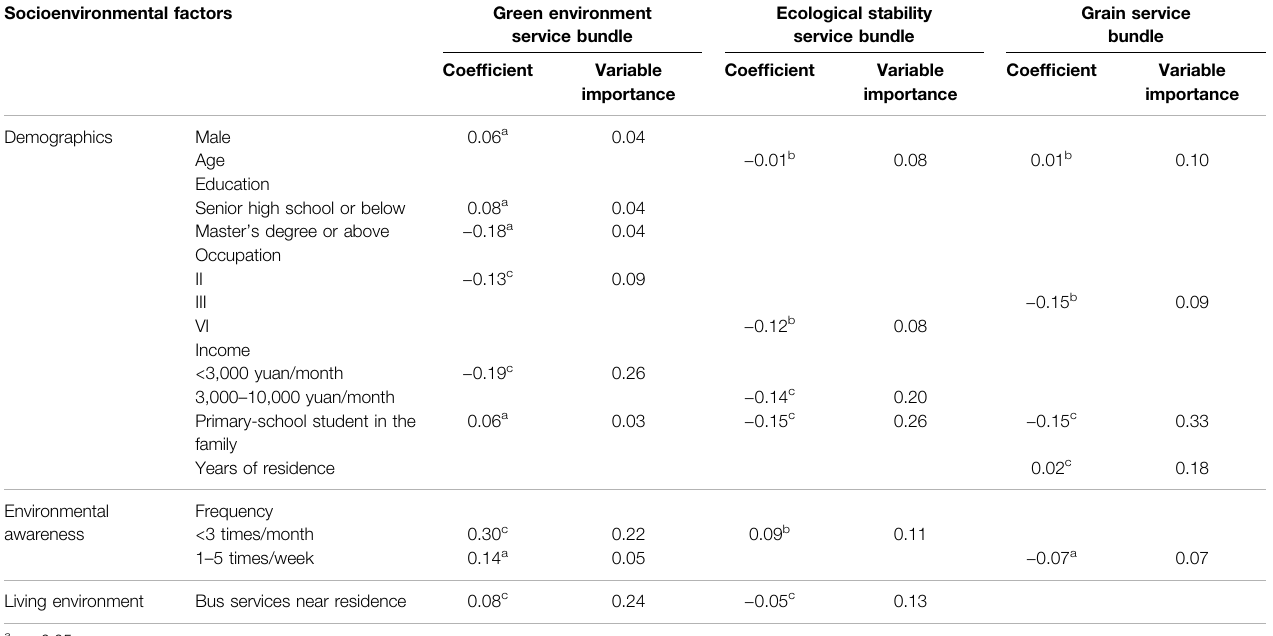
TABLE 3 | Automatic linear model of ES bundles on socialenvironmental variables, showing standardized beta coef fi cients with signi fi cant levels (parsimonious models). Socioenvironmental